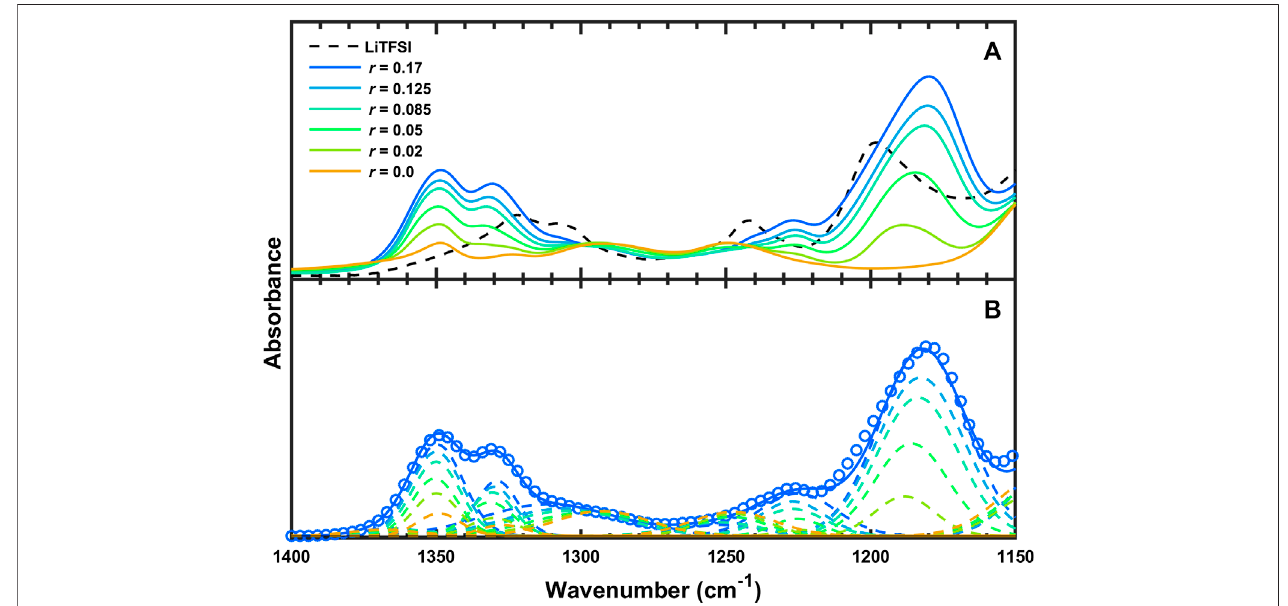
FIGURE 3 | (A) FTIR-ATR spectra and of SEO, LiTFSI, and SEO/LiTFSI from 1,400 to 1,150 cm − 1 and (B) experimental data (circles) and fi t (solid curve) of SEO/ LiTFSI ( r (cid:2) 0.17) as well as deconvoluted peaks (dashed curves) of SEO/LiTFSI at the various salt concentrations studied.